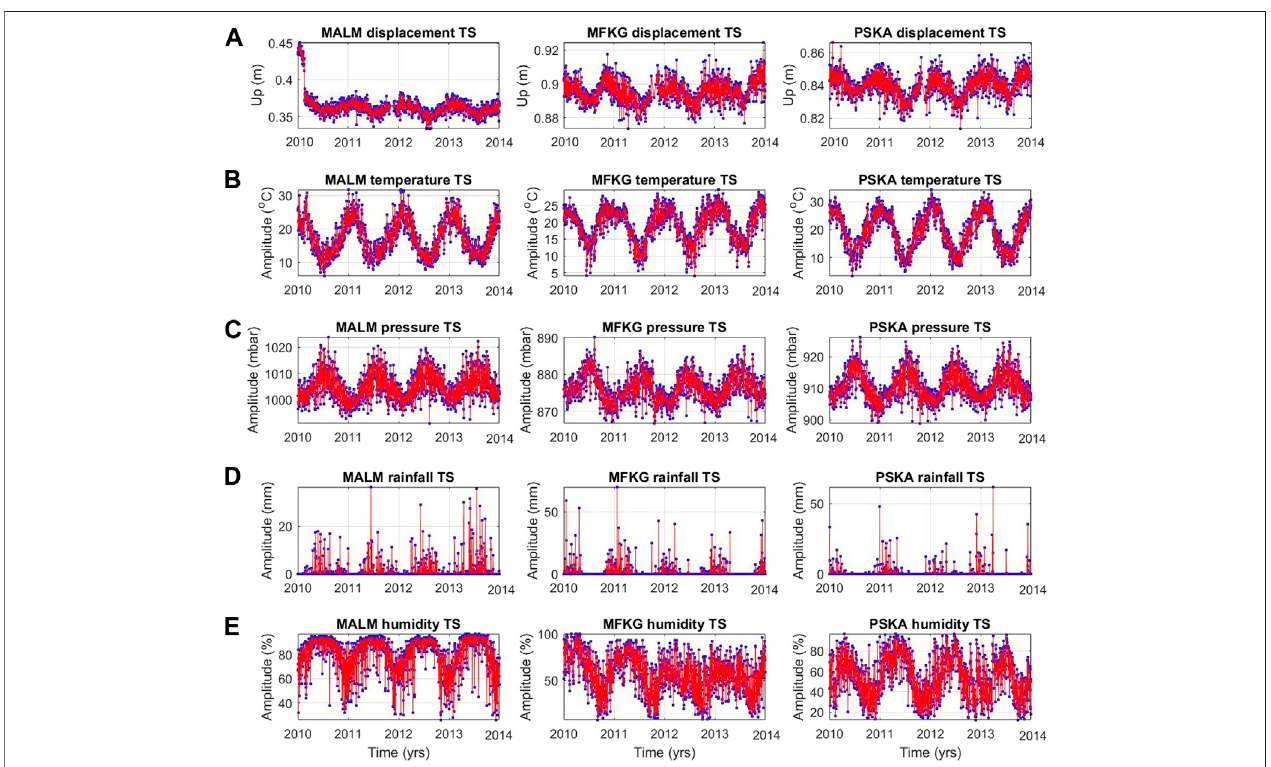
FIGURE 5 | Time domain displacement and meteorological time series at stations MALM, MFKG, and PSKA situated in the towns of Malmesbury, Mahikeng, and Prieska, respectively, the station names arethe abbreviationsofthetown names where they arelocated. (A) cGPS surface displacement, (B) atmospheric temperature, (C) atmospheric pressure, (D) rainfall, and (E) humidity time series across stations in southern Africa. Due to a lack of space and similarity of the results, results for only three stations are shown.